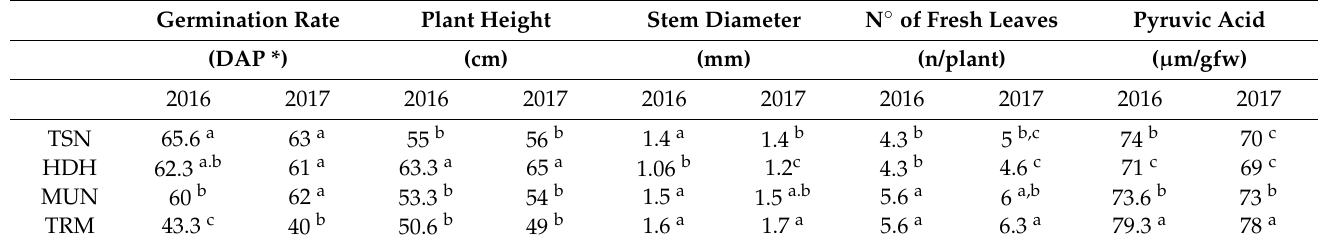
Table 2. Germination rate, plant height, stem diameter, number of leaves, and enzymatic pyruvic acid of Allium sativum in different